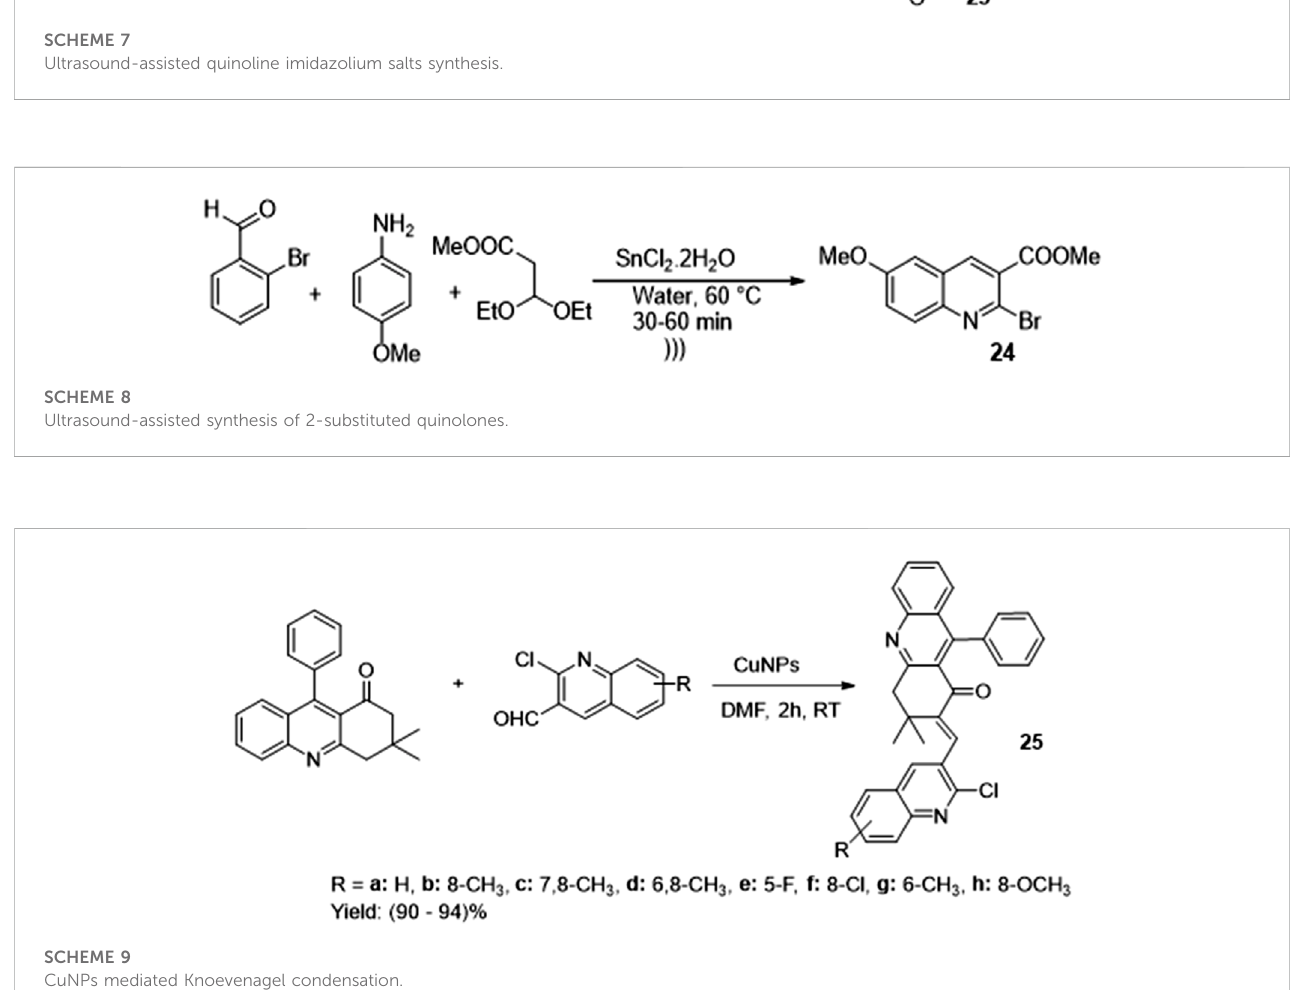
SCHEME 7 Ultrasound-assisted quinoline imidazolium salts synthesis.